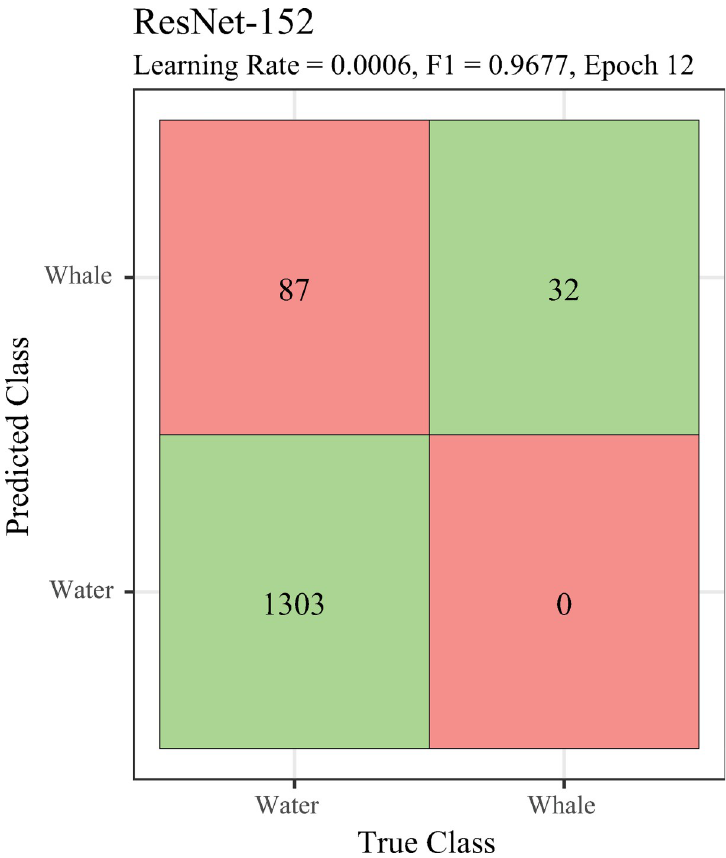
Fig 4. Model performance. Confusion matrix for the best model–ResNet-152. Full table of performance for all models available in S11 File.